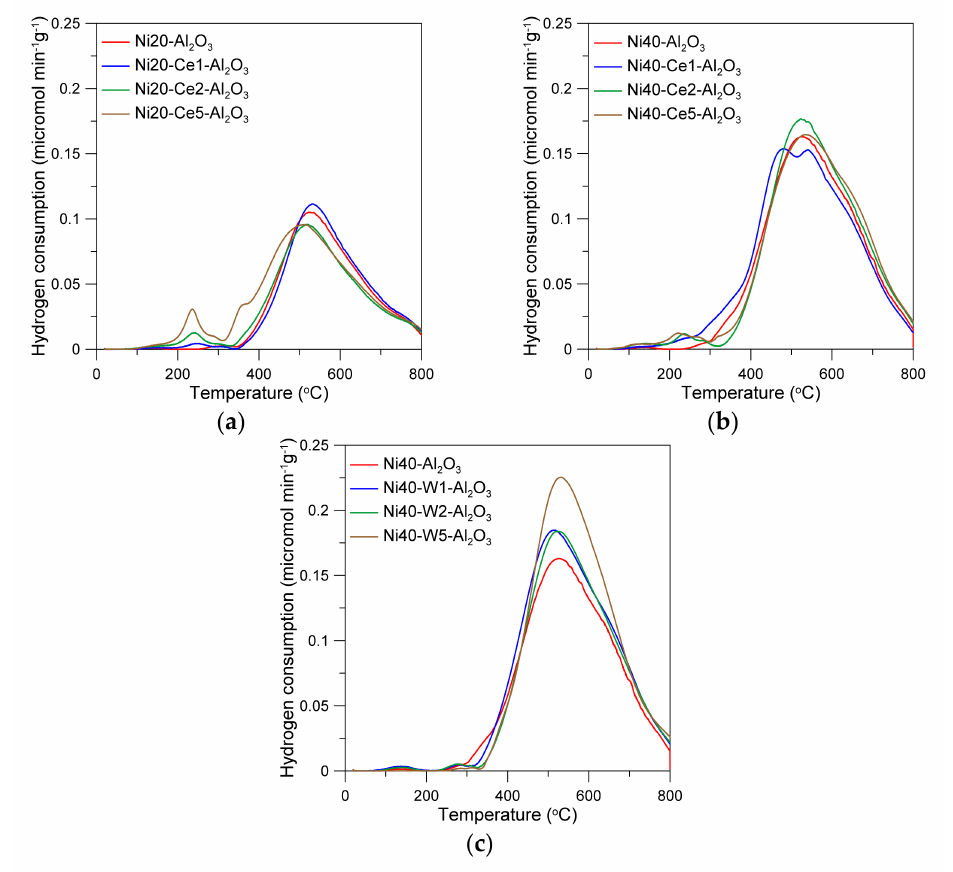
Figure 3. Temperature-programmed reduction curves of catalysts ( a – c